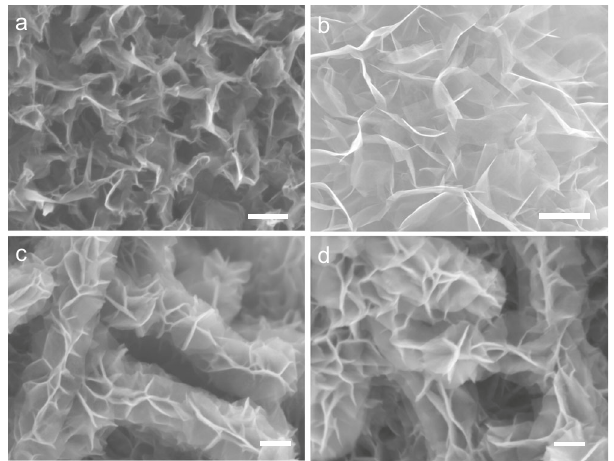
Fig. 2 SEM images of different samples. a CF/VGSs. b CF/VGSs/MoS 2 . c CF/VMFO. d CF/VMFP. Scale bars: a 200 nm; b 1 μ m; c , d